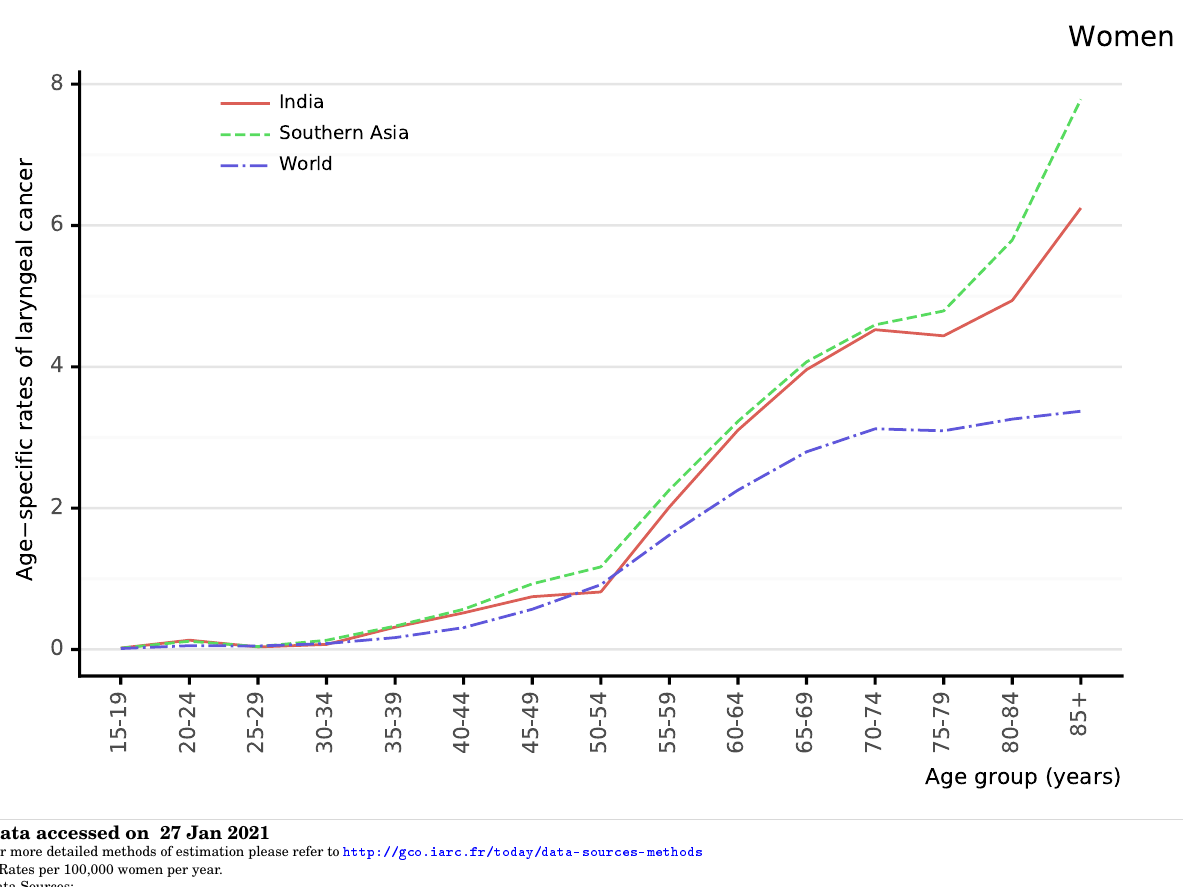
Figure 104: Comparison of age-specific laryngeal cancer incidence rates among women by age in India, within the region, and the rest of